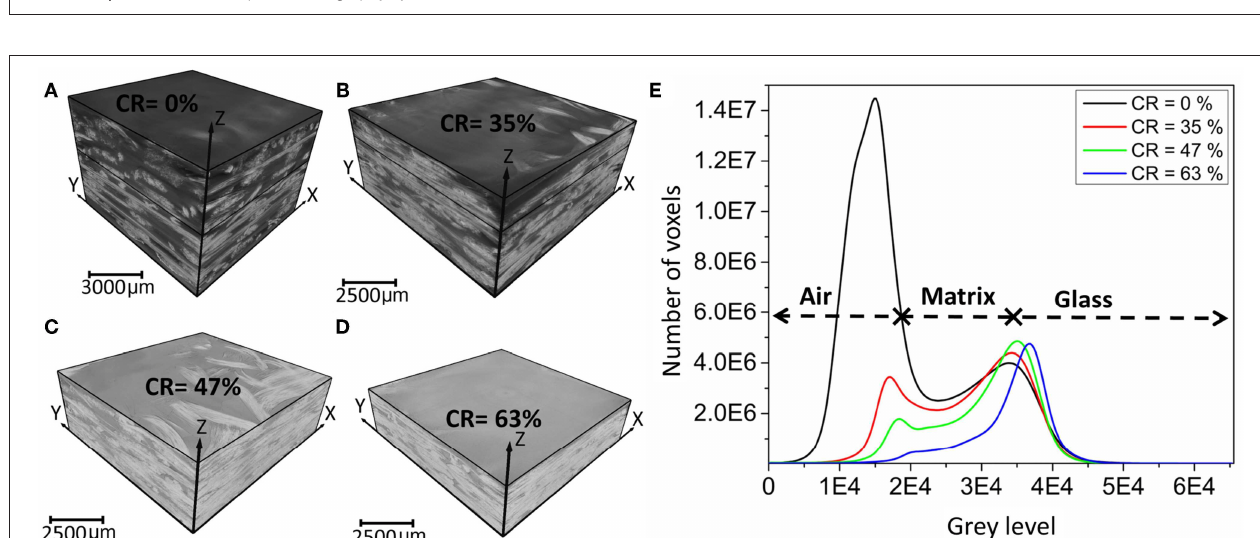
FIGURE 2 | Photo of the computed tomography system of the ISIS4D Platform.